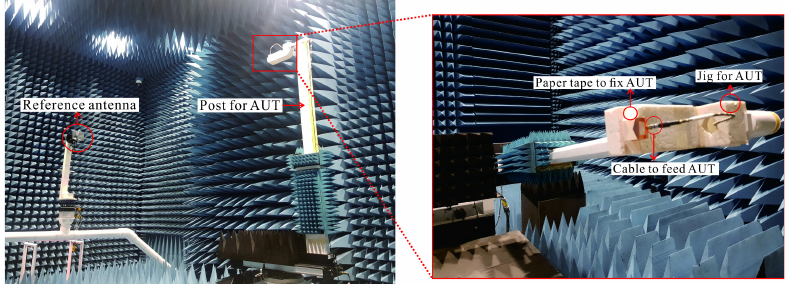
Figure 12. Photograph of the anechoic far-field chamber for measuring the radiation pattern of the proposed antenna.